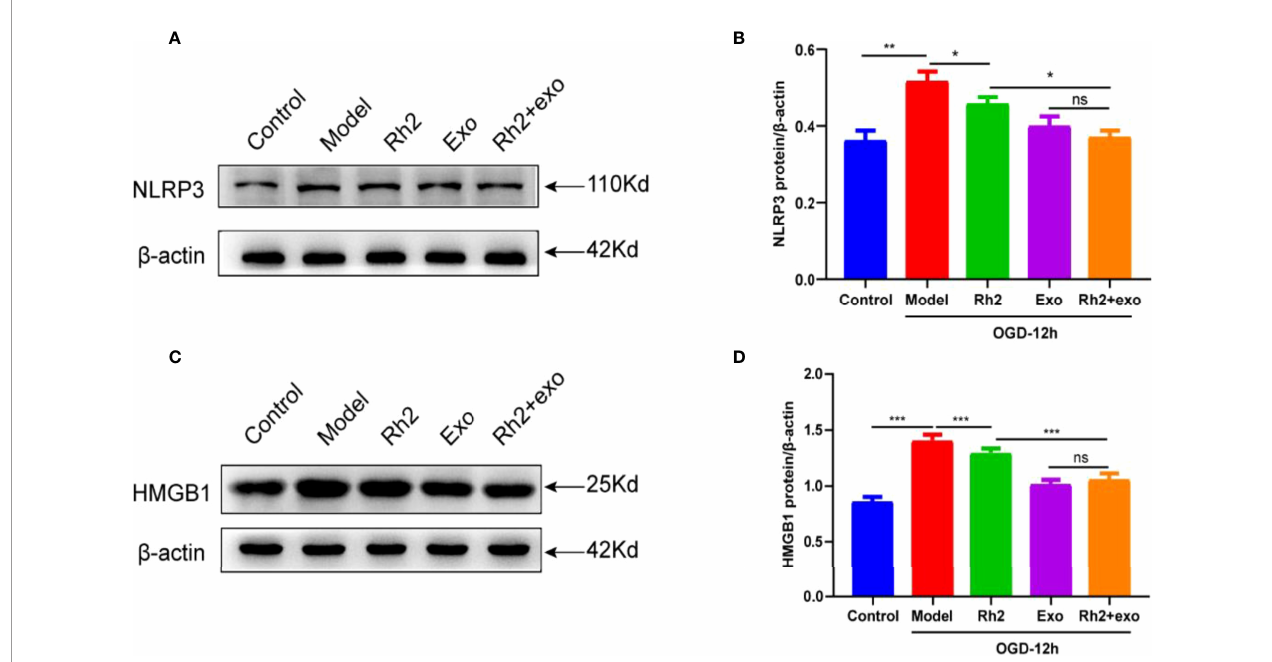
FIGURE 6 | Ginsenoside Rh2 inhibited NLRP3 in fl ammasome activation via HMGB1/NF- k B signaling to promote exosome therapy for myocardial injury. Representative images of western blotting (A, C) and quantitative data (B, D) of the protein levels of NLRP3 and HMGB1. One-way ANOVA test was used for statistical analyses. Bars represent means ± SD; *P < 0.05, **P < 0.01, ***P < 0.001 . ns, no signi fi